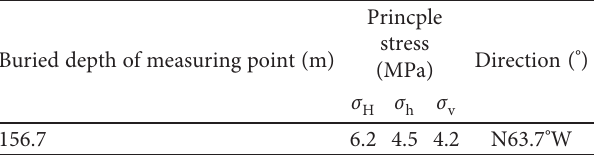
Table 1: Ground stress measurement result. Buried depth of measuring point (m)